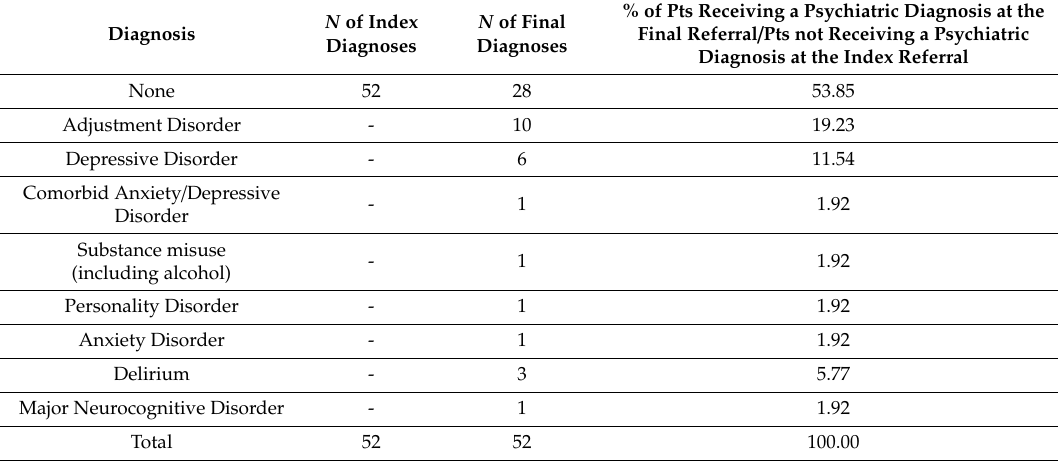
Table 3. Number of negative diagnoses at the index referral (total N = 52) subsequently turned into positive diagnoses (disaggregated by type of